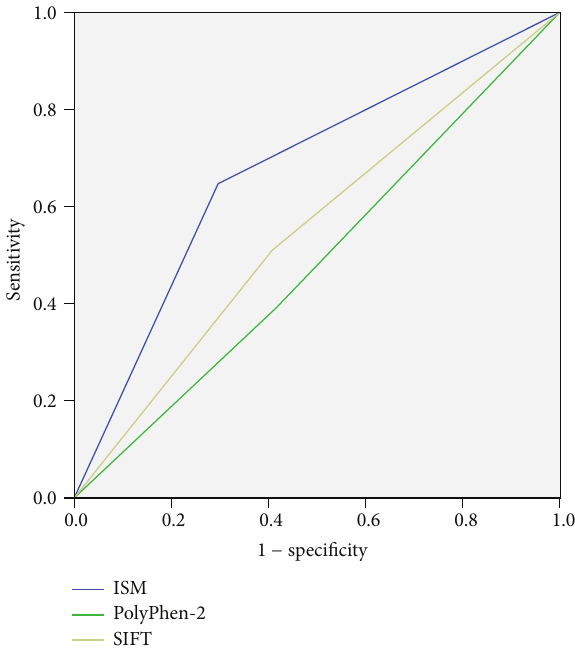
Figure 6: ROC curves for binary